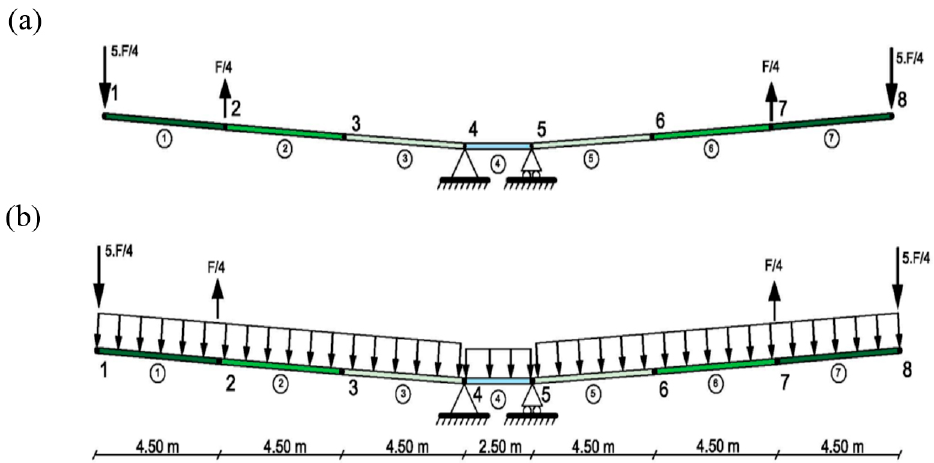
Figure 12. Loading case: ( a ) loads from the formwork traveler and ( b ) modeled loading case.